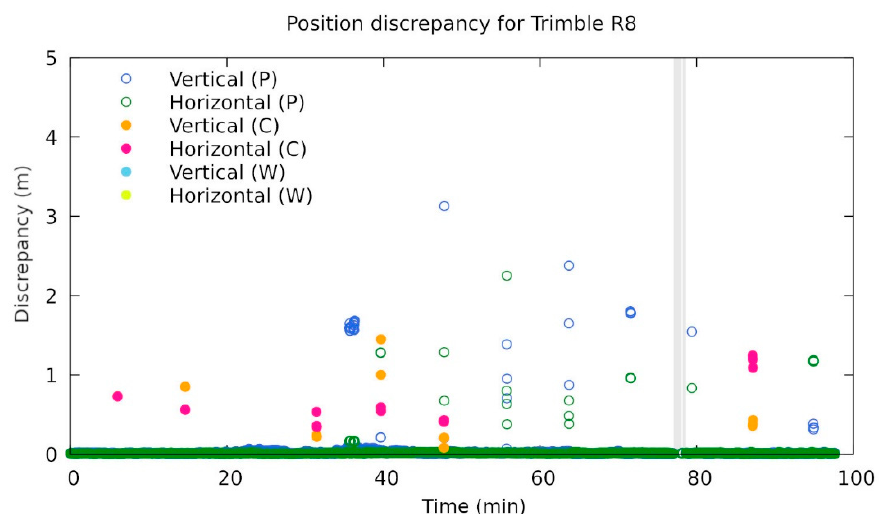
Figure 13. Discrepancies of the reported position for Trimble R8 (note the zoomed scale). See Figure 12 for a detailed description of the annotations. Those points that are above 1 m and reported as a phase fix were particularly problematic (own study).